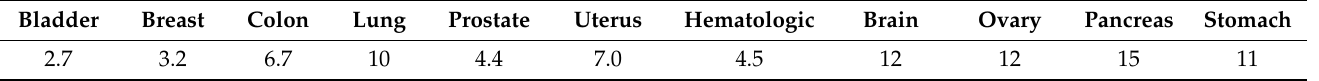
Table 1. Incidence rate of first VTE per 100 person-years by cancer type among adult patients with active cancer in UK [9]. Bladder Breast